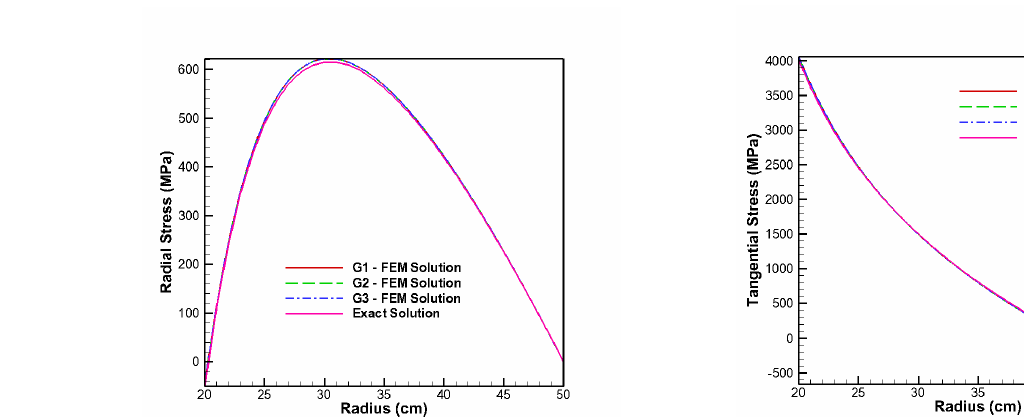
= 𝑇 = 0 𝑜 𝐶 , 𝑟 𝑖 𝑟𝑒𝑓